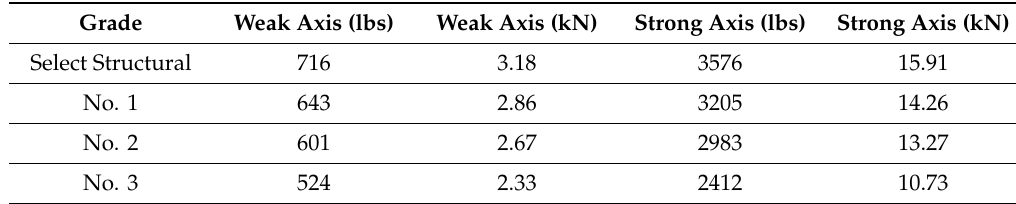
Table 1. The buckling loads of various timber grades of Douglas fir.